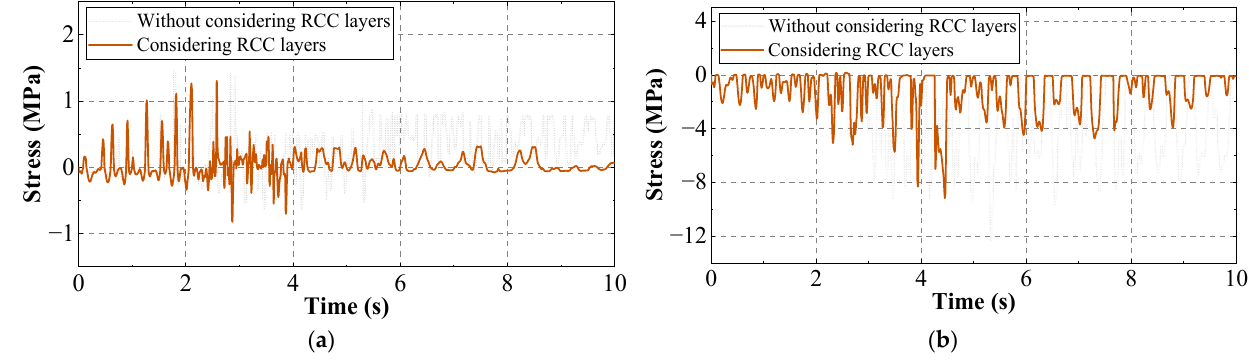
Figure 24. Stress time histories near the change in downstream slope. ( a ) Maximum principal stress; ( b ) minimum principal stress.